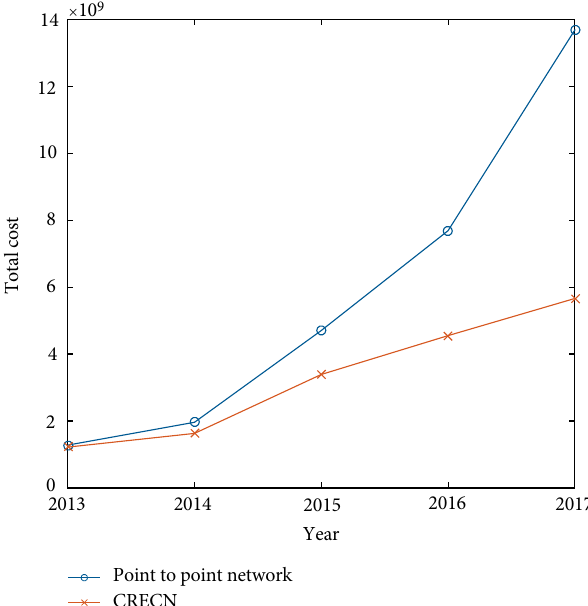
Figure 9: Total cost comparison between point-to-point network and CRECN.